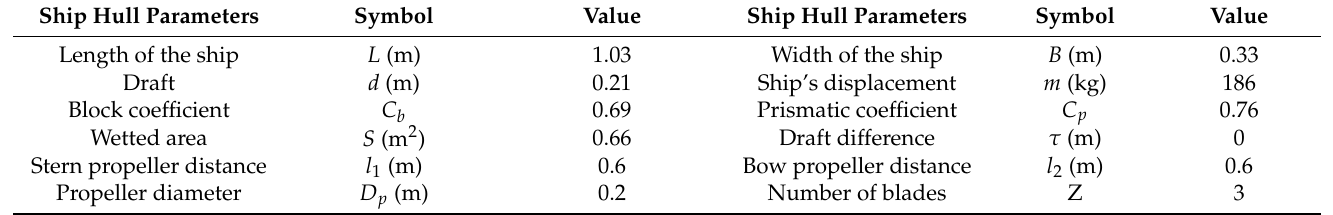
Figure 1. Unmanned ship structure. Figure 2. Schematic diagram of the computational domain. Table 1. Unmanned ship hull parameter.